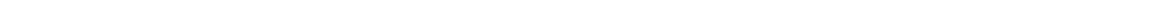
Fig. 5 Distinct TNF pathways determine the cell's fate during virus infection. a – c A549 CRISPR control (CTRL), IFNAR1 KO, and MAVS KO cells mock- infected or infected with SeV HD for 24 or 48 h. a Merged representative RNA FISH-IF images of active caspase-3 positive staining. Magni fi cation: ×40. Scale bar = 20 μ m. b Percentage of active caspase-3 positive cells within each infected culture ( n = 8). c Percentage of active caspase-3 positive cells within the FL-high and DVG-high populations of each culture ( n = 8). d TNF α in the supernatant of A549 CTRL, IFNAR1 KO, and MAVS KO cells mock infected or infected with SeV for 24 h. One representative experiment is shown, bar = mean ± s.e.m. of technical triplicate. e Percentage of active-caspase 3 positive MAVS KO cells infected with SeV HD for 16 h and either left un-treated (UT), treated with recombinant IFN-beta (IFN β , 100U), or treated with recombinant TNF α (10 ng/ml) for 8 h. ( n = 3). f , g A549 cells were infected with SeV HD and incubated with control IgG antibody or antibodies against TNF α , TNFR1, and TNFR2 (anti-TNF Combo). f Percentage of apoptotic A549 cells from the total population ( n = 4). g Percentage of active caspase-3 positive cells within FL-high and DVG-high cells ( n = 4). h , i MAVSKO A549 cells were infected with SeV HD for 16 h and then incubated with recombinant TNF α at 0, 0.05, 1, and 10 ng/ml for 8 h. h . Percentage of active caspase-3 positive cells among total cells ( n = 3 – 6). i Percentage of active caspase-3 positive staining cells within FL-high and DVG-high cells ( n = 3). Data are shown as mean ± s.e.m. of fold change over UT at each TNF α dosage. * P < 0.05, ** P < 0.01, *** P < 0.001, and **** P < 0.0001 by one-way ( e , h ) or two-way ( b , c , f , g , i ) ANOVA with Bonferroni ’ s post hoc test. ns, non-signi fi cant. ND, non-detected. See also Supplementary Fig.